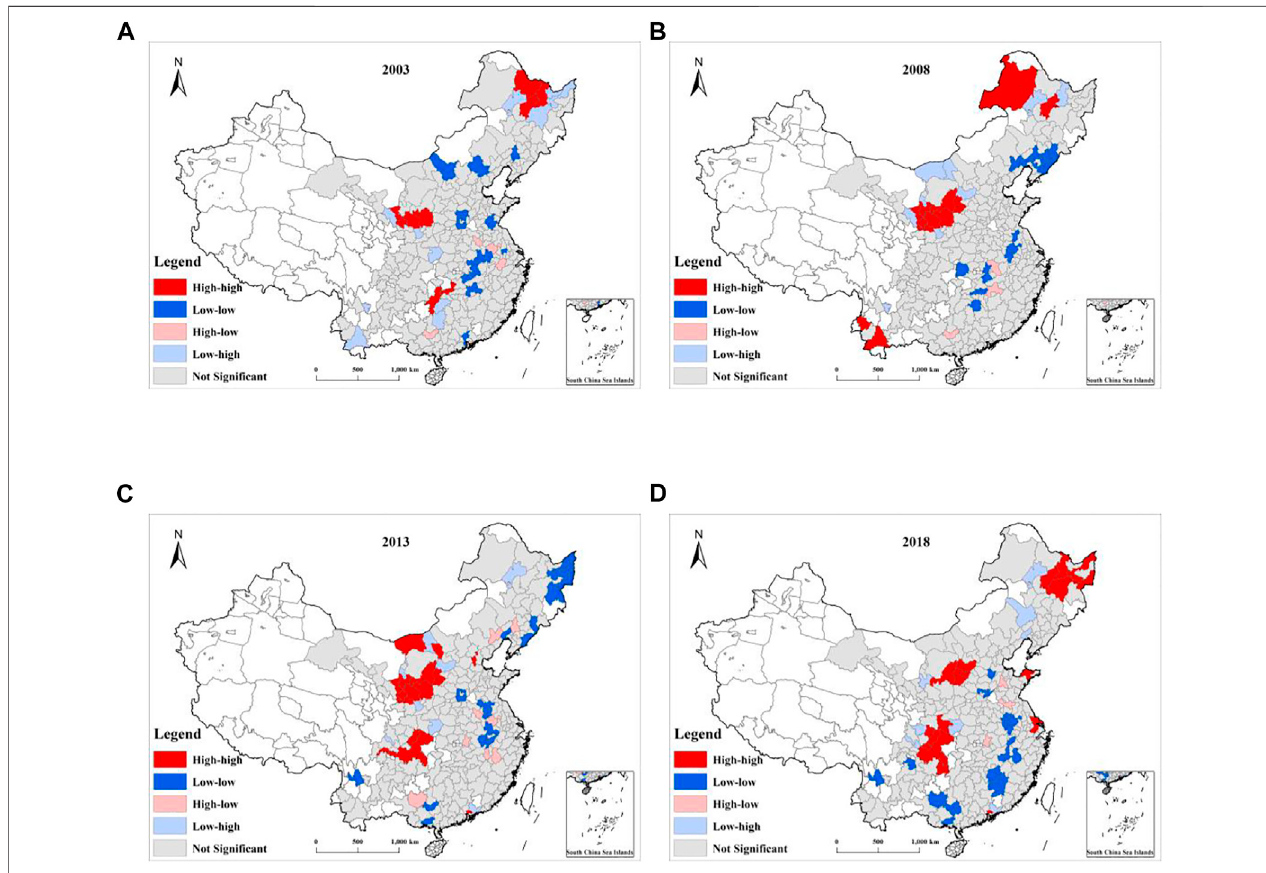
FIGURE 4 | Local spatial autocorrelation of UWUE in China between 2003 and 2018. (A) 2003; (B) 2008; (C) 2013; (D) 2018. Note: This fi gure shows only the results of 4 years, and the others can be seen in Supplemental Materials .